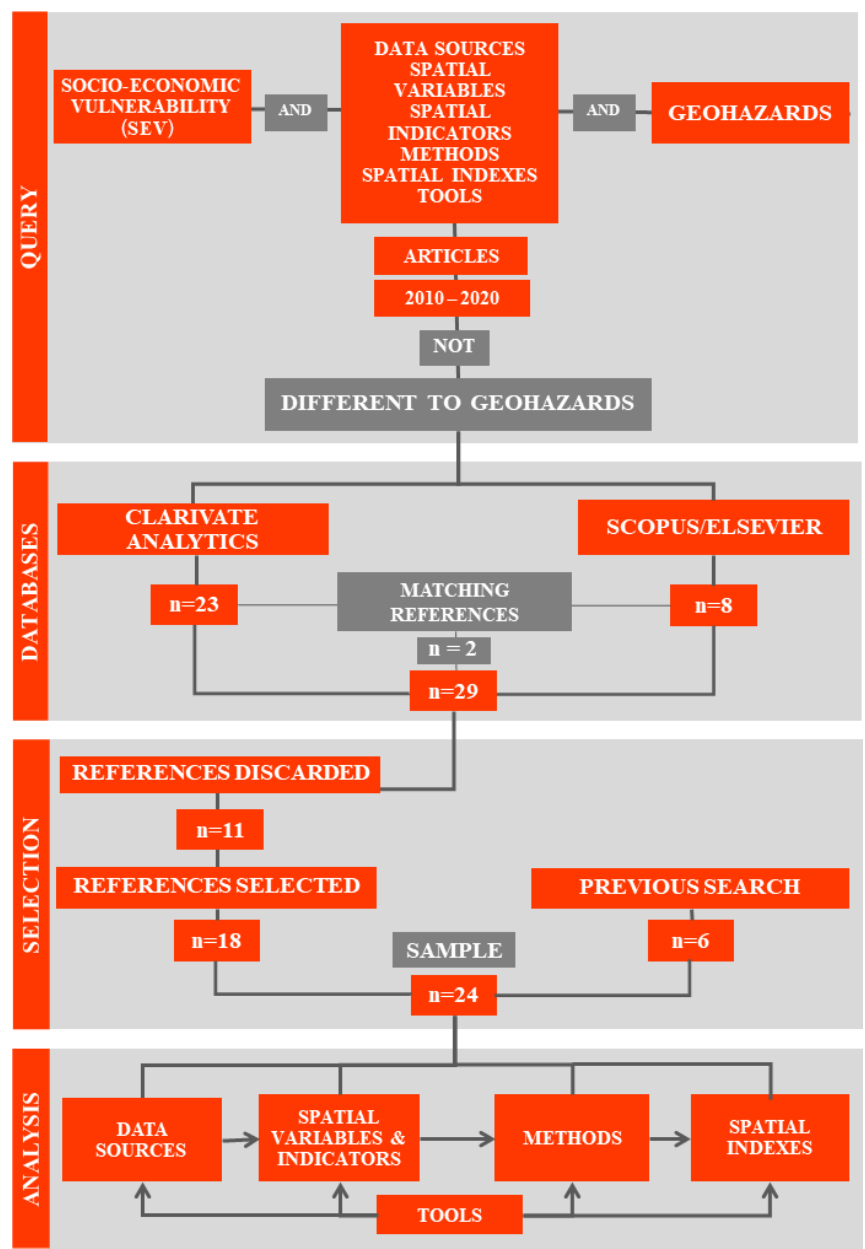
Figure 1. Methodology applied for the systematic literature